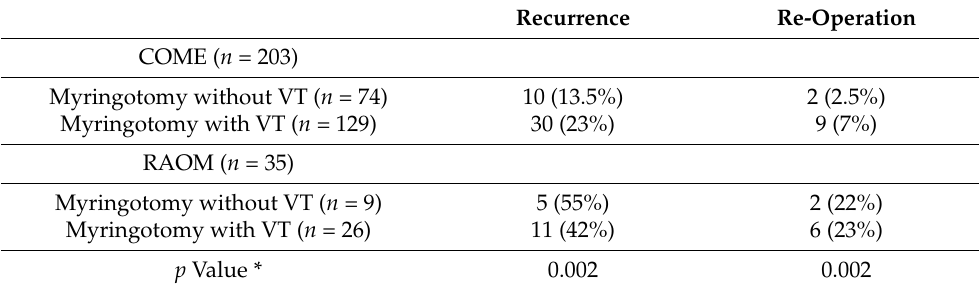
Table 7. Recurrence and re-operation cases of COME and RAOM according to initial surgical procedure.